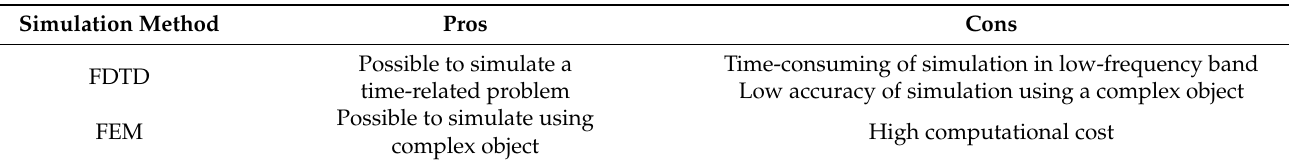
Table 2. The characteristics of simulation methods for the electric field.